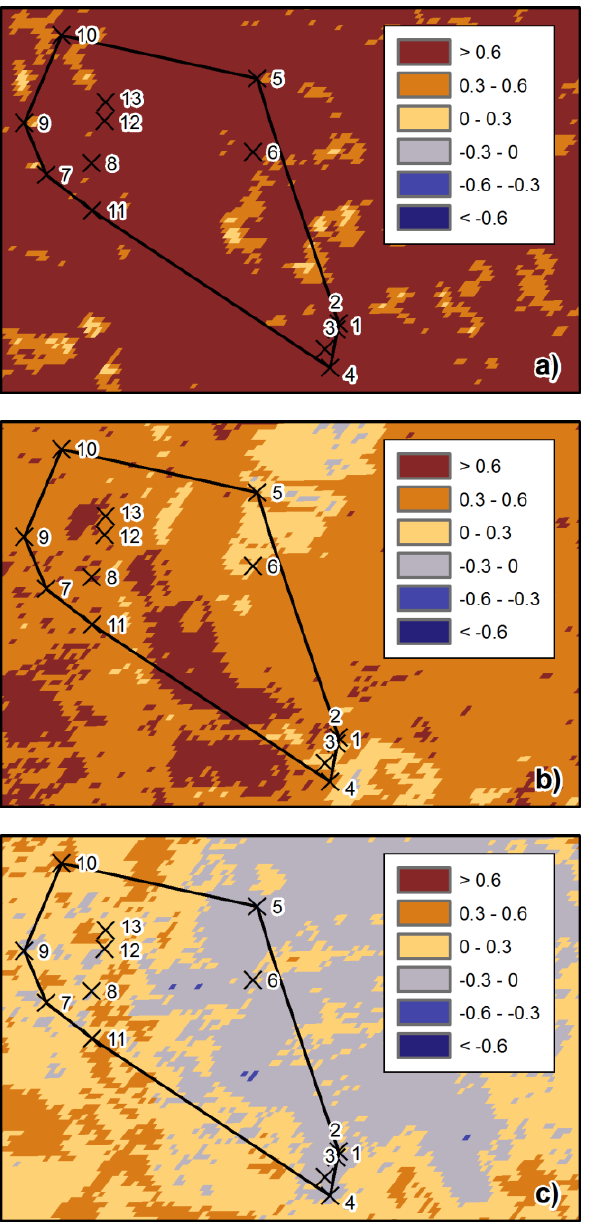
Figure 6. Spatial distribution of the correlation coefficients Figure 7. Spatial distribution of the correlation coefficients between NDVI and air temperature in the spring (a), summer between NDVI and total precipitation in the spring (a), summer (b) and autumn (c) seasons (b) and autumn (c) seasons In summer season, the degree of correlation between NDVI and Also in autumn season the negative correlation values observed air temperature decreases. Maximum significant correlation on non-forest lands. The greatest negative values of correlation coefficient values were observed on the territories occupied by coefficient are observed on the floodplains. The coefficient non-forest lands. Minimum coefficient values were observed on values of correlation between the precipitation sums and vegetation index magnitudes are always positive on the have the negative values of correlation coefficient. The territories of evergreen coniferous